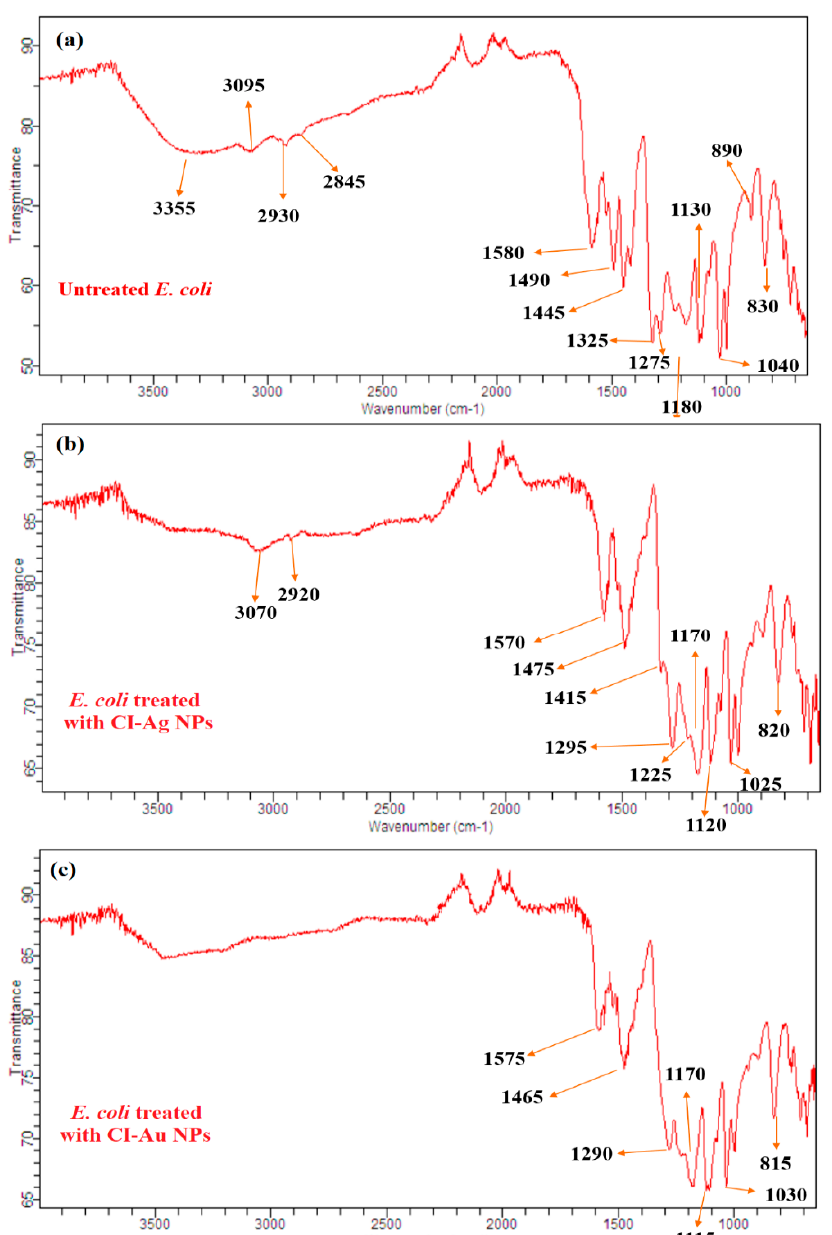
Figure 11. FTIR of ( a ) untreated and treated E. coli with ( b ) CI-Ag NPs and ( c ) CI-Au NPs synthesized by using C. inerme leaves extract.